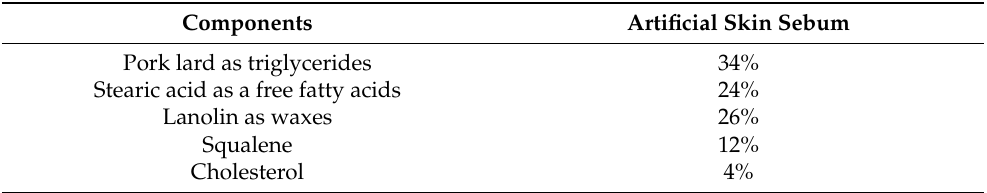
Table 3. Components of the artificial skin sebum. Components Artificial Skin Sebum Pork lard as triglycerides 34% Stearic acid as a free fatty acids 24% Lanolin as waxes 26% Squalene 12% Cholesterol